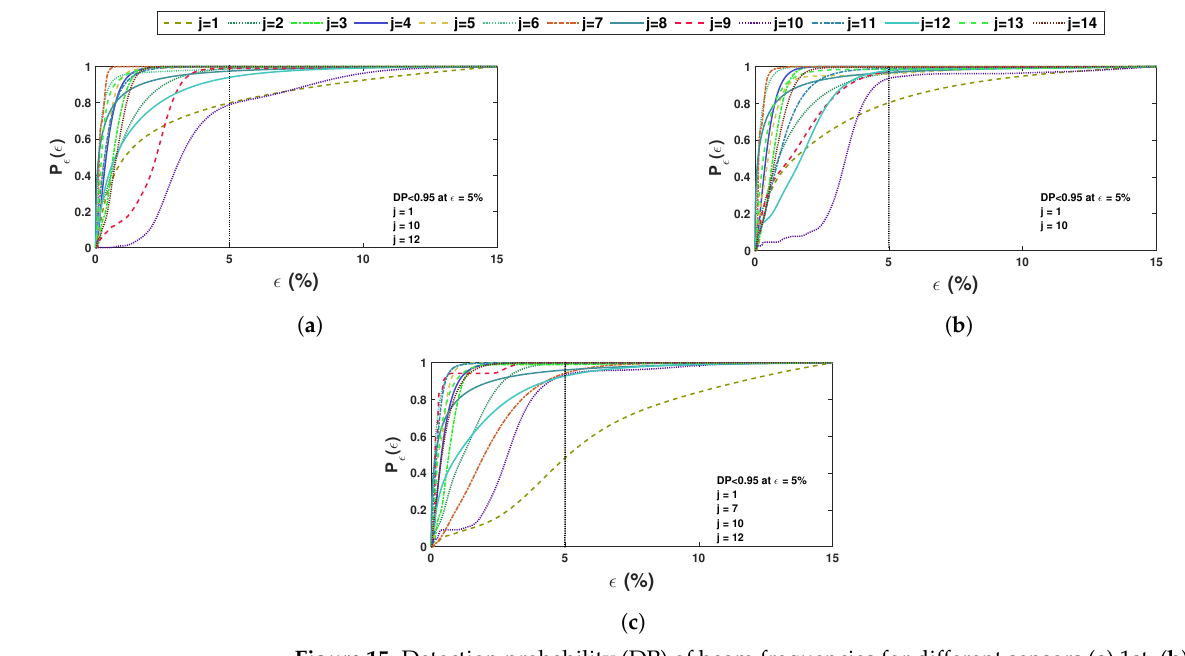
Figure 15. Detection probability (DP) of beam frequencies for different sensors ( a ) 1st, ( b ) 2nd and ( c ) 3rd sensor [NB: DP represents ’detection probability’ of a particular mode].